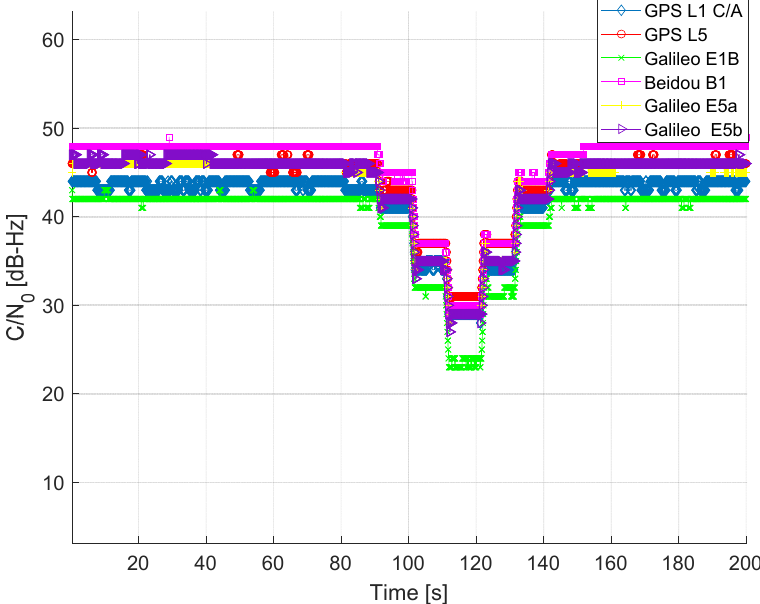
Figure 9. Average C/N 0 of tracked GNSS signals during the presence of jamming in lower and upper L-band.